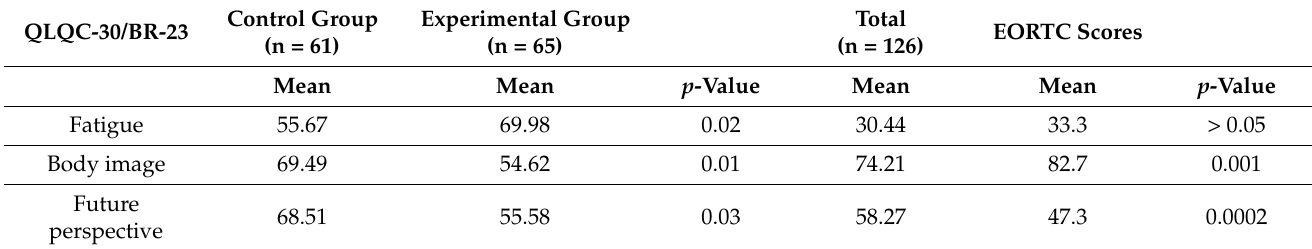
Table 4. Evaluation of quality of life using QLQC-30 and BR-23 inventories: fatigue, body image, future perspective.